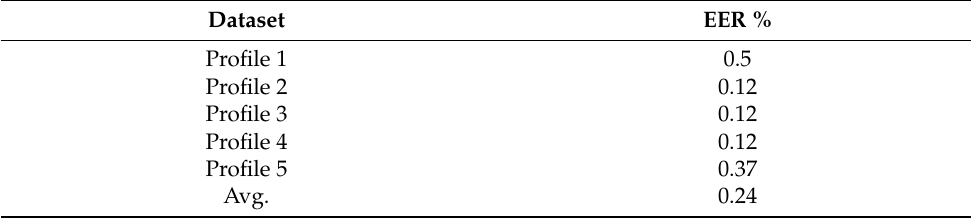
Table 15. Authentication ERR of VGG-19-F6 deep features after applying PCA (95%).